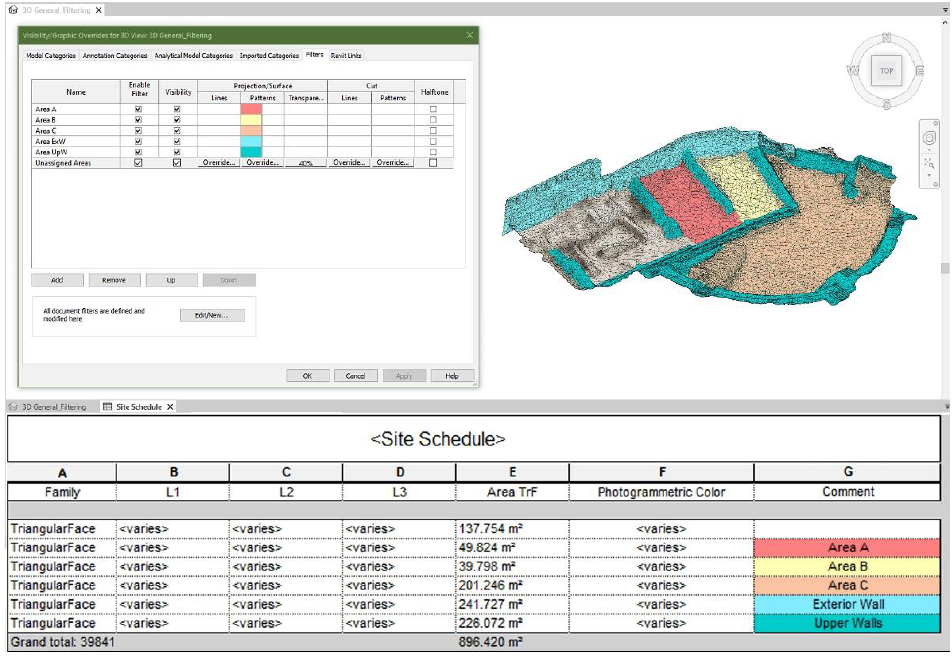
Figure 15. Overview of the visual filtering and scheduling possibilities resulting from Workflow B application (e.g., north detailed area).